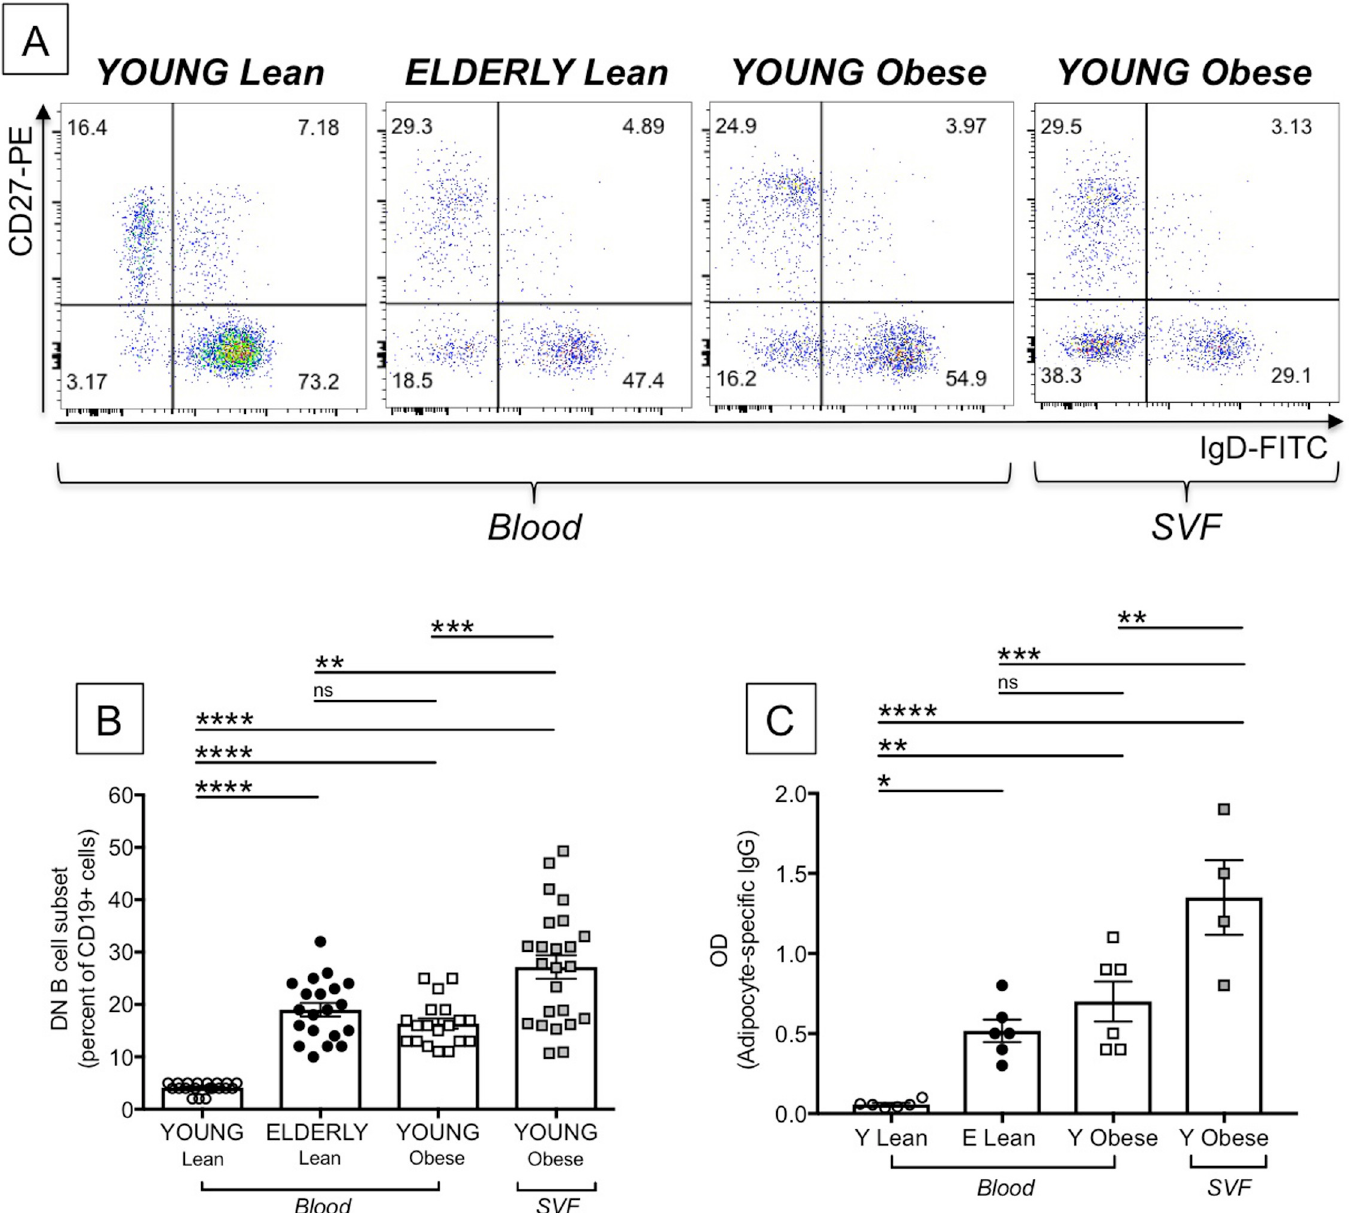
Fig 5. Effects of aging and obesity on the frequency and function of DN B cells. PBMC from the blood from young and elderly lean individuals and from the blood of young obese individuals were stained to evaluate the frequencies of DN B cells. The SVF from the SAT of young obese individuals was also stained. Young individuals giving PBMC and the SAT were age-, gender- and BMI-matched. A. Representative dot plots are shown. B. Results are expressed as percentages of CD19+ B cells. C. Sorted B cell subsets were left unstimulated in culture for 10 days, then supernatants were collected and tested in ELISA for the presence of IgG specific for protein lysates from the SAT. Mean comparisons between groups were performed by one-way ANOVA. �� p < 0.01, ��� p < 0.001, ���� p < 0.0001, ns: not significant.